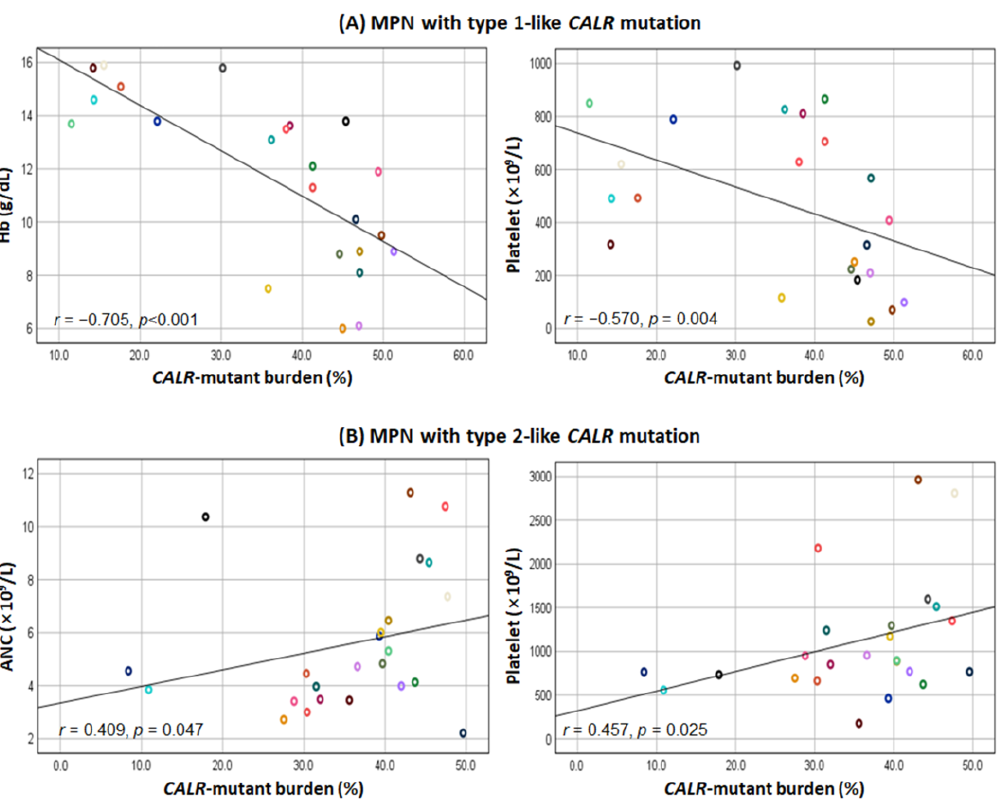
Figure 2. ( A ) Scatter plots between CALR -mutant burden and hemoglobin (Hb) level and platelet count in MPN patients with type 1-like CALR mutation; ( B ) scatter plots between CALR -mutant burden and absolute neutrophil count (ANC) and platelet count in MPN patients with type 2-like CALR mutation. Circles of the same color in each group indicate the same patient.